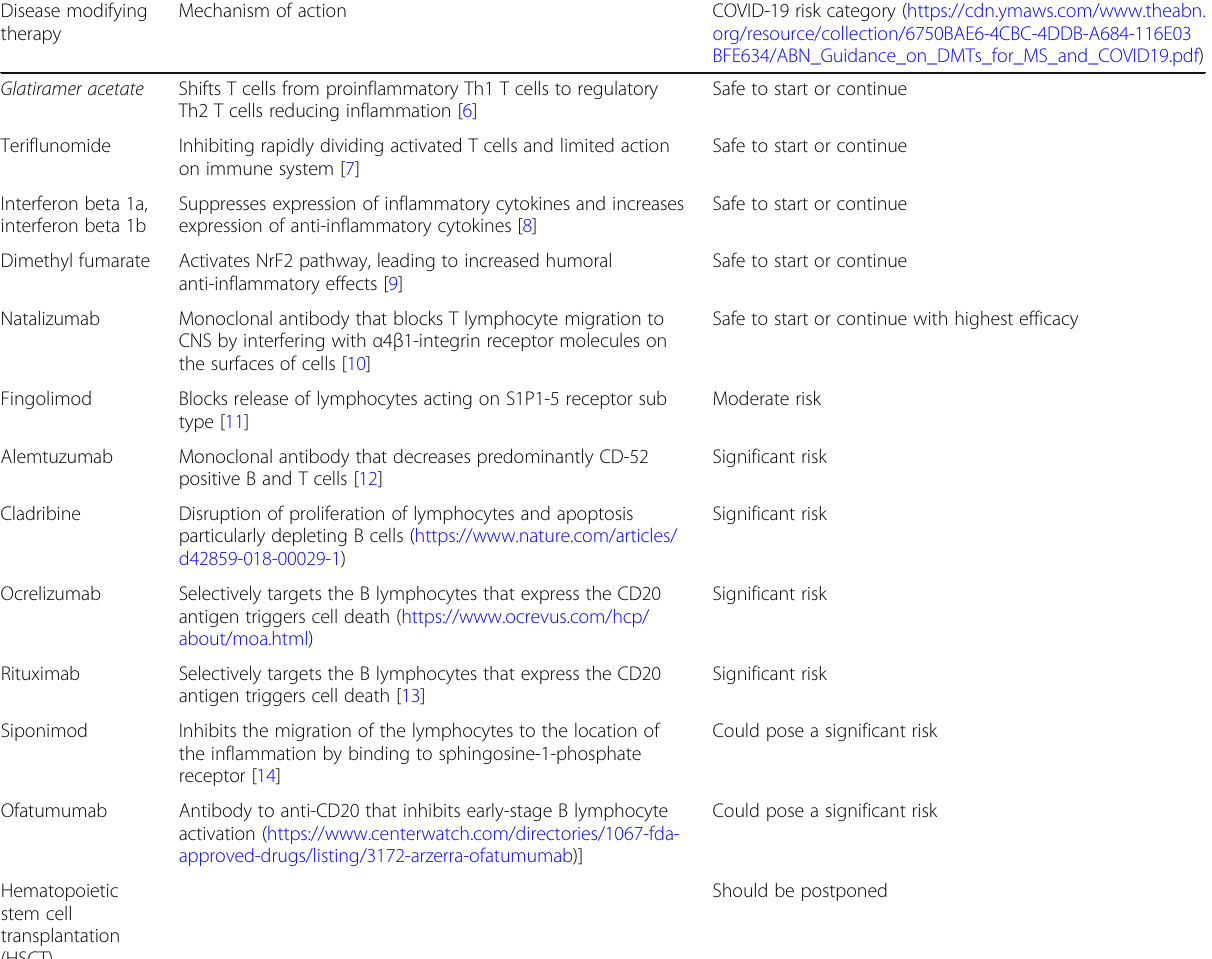
Table 1 Disease modifying therapies and their probable risk categories (https://cdn.ymaws.com/www.theabn.org/resource/ collection/6750BAE6-4CBC-4DDB-A684-116E03BFE634/ABN_Guidance_on_DMTs_for_MS_and_COVID19.pdf) Disease modifying Mechanism of action therapy Glatiramer